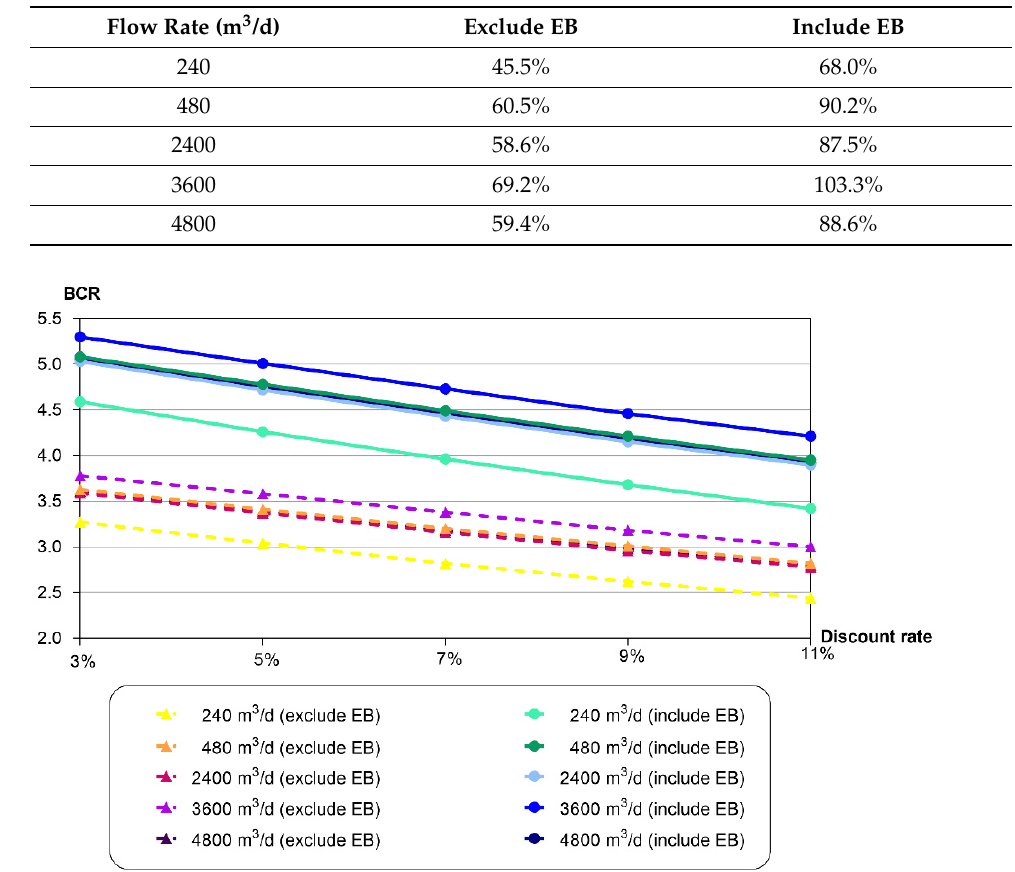
Figure 6. NPVs for water reclamation projects for the irrigation of plants and green areas when including and excluding environmental benefits (EB). Table 5. Internal rates of return for water reclamation projects for the irrigation of plants and green areas when including and excluding environmental benefits (EB).